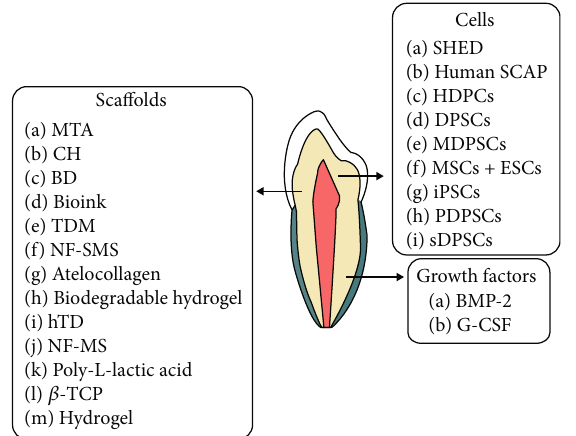
Figure 2: Diagram showing cells, growth factors, and sca ff olds examined in the fi eld of dentin